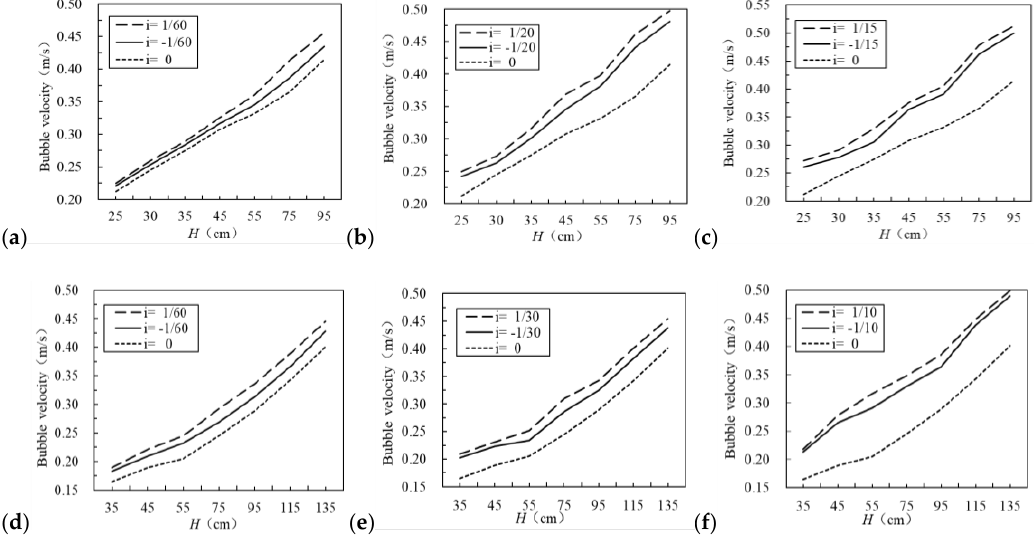
Figure 7. Comparison of the bubble velocity in the middle part of pipe on the positive, flat, and reverse slopes: ( a ) h s = 4 m and i = ±1/60, ( b ) h s = 4 m and i = ±1/20, ( c ) h s = 4 m and i = ±1/15, ( d ) h s = 6 m and i = ±1/60, ( e ) h s = 6 m and i = ±1/30, ( f ) h s = 6 m and i = ±1/10.